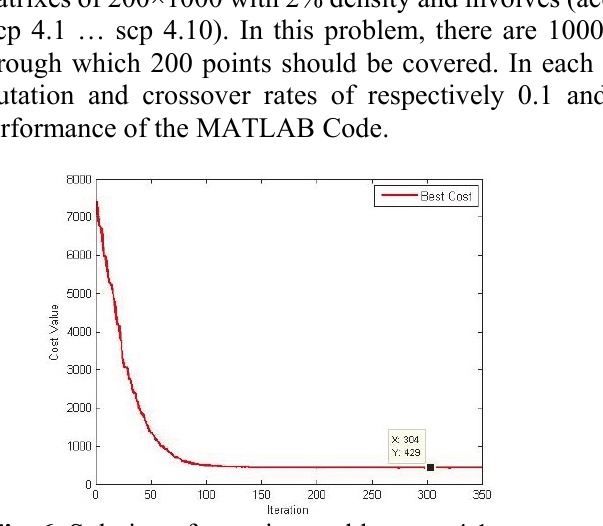
Fig. 6. Solution of covering problem scp 4.1 Fig. 7. Solution of covering problem scp